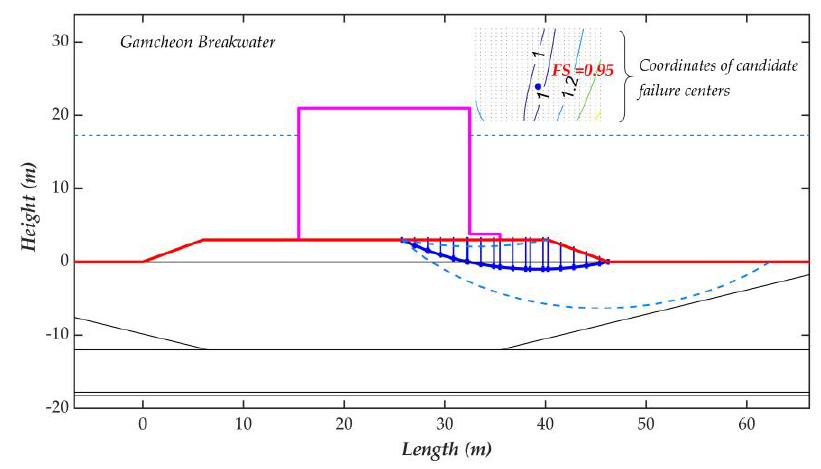
Figure 11. Bearing capacity analysis applying Bishop’s simplified method (BSM) conjugated with MCS.